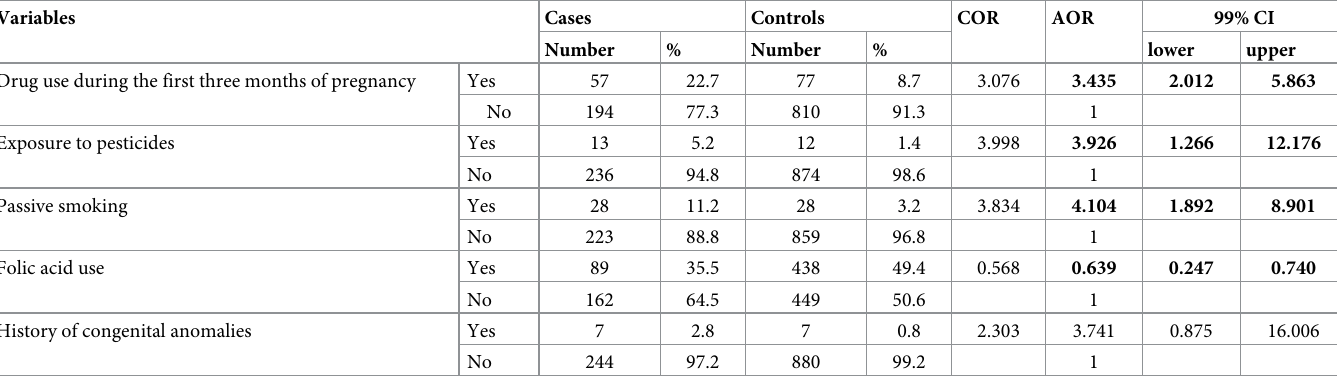
Table 6. Responses of study subjects on possible risk factors for CAs: Multivariable analysis of AOR for associated risk factors of CAs in southwestern Ethiopia. Variables Cases Drug use during the first three months of